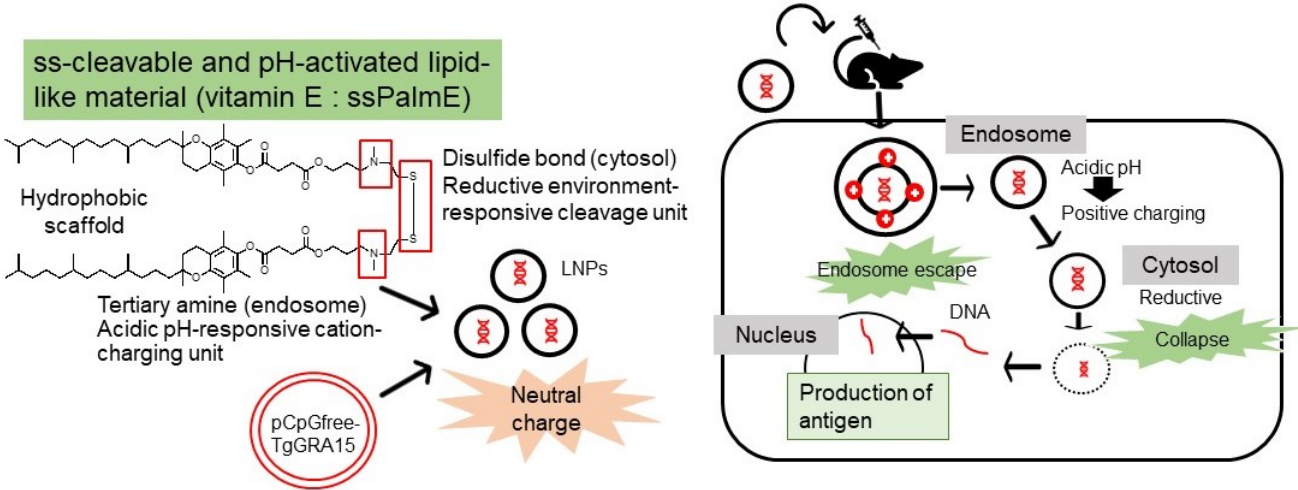
Figure 4. Mechanism of action of ssPalmE-LNP TgGRA15. ssPalm contains two hydrophobic scaffolds to form a stable lipid bilayer. For membrane destabilization, proton-sponge units are positively charged at an acidic pH (endosome/lysosome) in the two tertiary amines. In reducing environment (cytosol), disulfide bonding is cleaved. Following cellular uptake and in response to the intracellular environment, the LNP is degraded, which leads to the release of the cargo or antigen (TgGRA15).